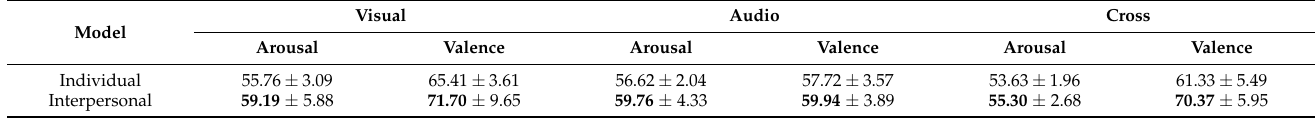
Table 6. The Supplementary Experiment Result (F1-Score).